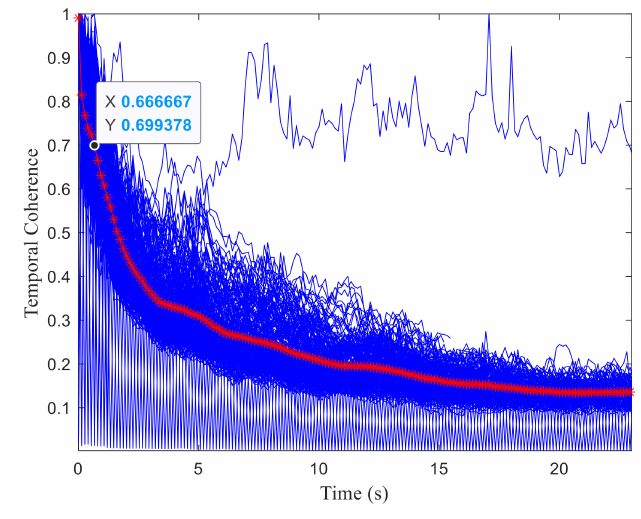
Figure 14. Temporal coherence of UWA channel.